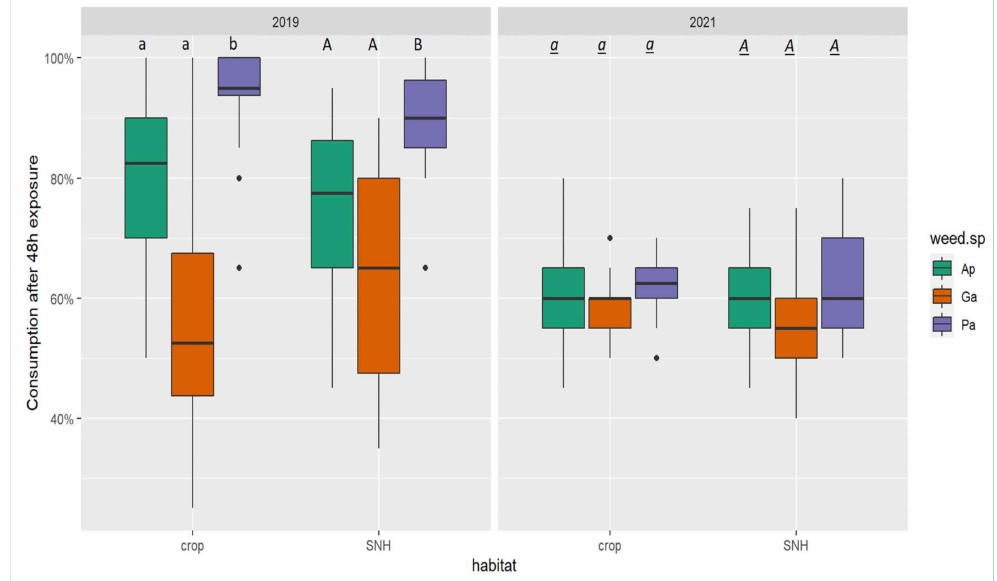
Figure 4. Seed consumption after 48 h of weed species Ap: Apera spica-venti , Ga: Galium aparine ,